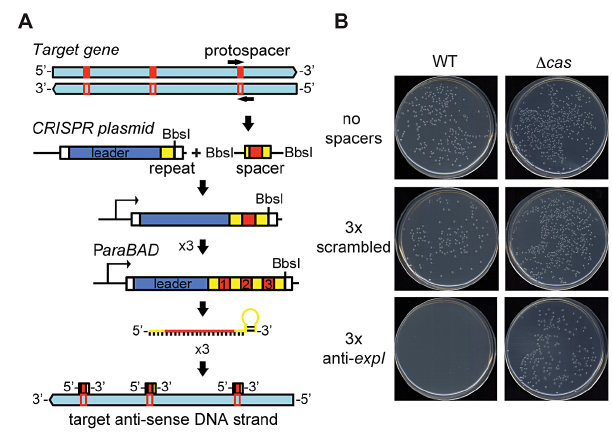
Figure 1. An engineered CRISPR plasmid with spacers target- ing the chromosome displays Cas–dependent toxicity. (A) Strategy for chromosomal targeting (see Materials and Methods). Protospacers were PCR-amplified from target DNA with full or partial repeats and BbsI sites on the primers. PCR products were digested with BbsI and cloned into BbsI-digested plasmids containing a leader sequence and one repeat. This process was repeated to generate multiple spacer inserts. These arrays generate crRNAs that target the template DNA strand but not the mRNA. (B) Transformation plates of P. atrosepticum WT or a D cas mutant (PCF80) after growth for 36 h on LBA containing Ap. Plasmids transformed contained no spacers (pC1-780), 3 scrambled spacers (pS3-780) and 3 anti- expI spacers (pE3-780). Representatives are shown from experiments performed at least in